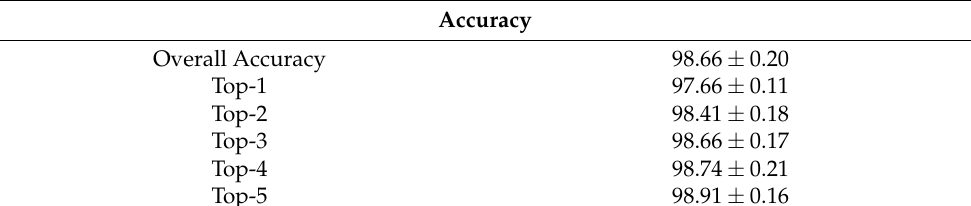
Table 6. The accuracy of the proposed system on the first session dataset with 50% for training and 50% for testing.